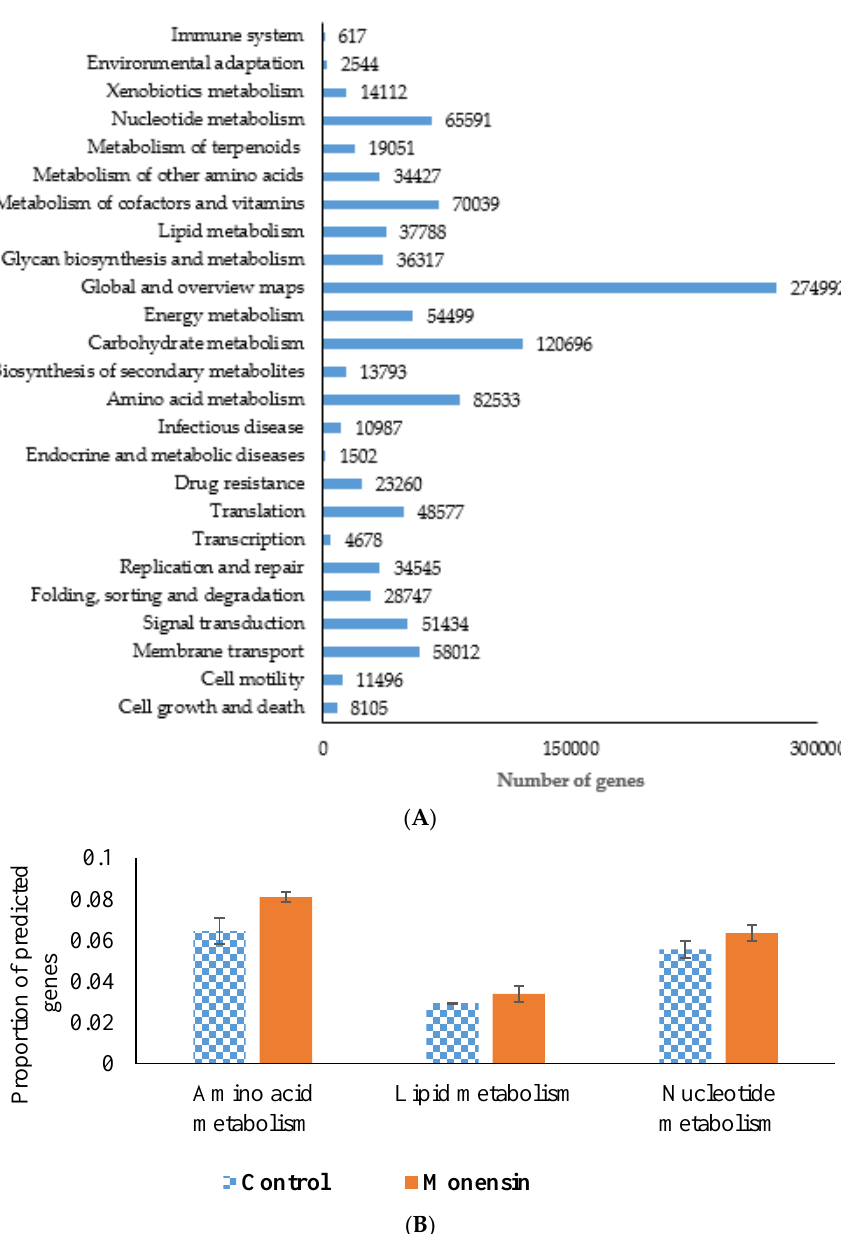
Figure 2. ( A ) Distribution of category of the predicted genes by KEGG. ( B ) Differential KEGG gene functions. Differences between control and monensin samples were tested for significance using a Mann Whitney test ( p ≤ 0.05).